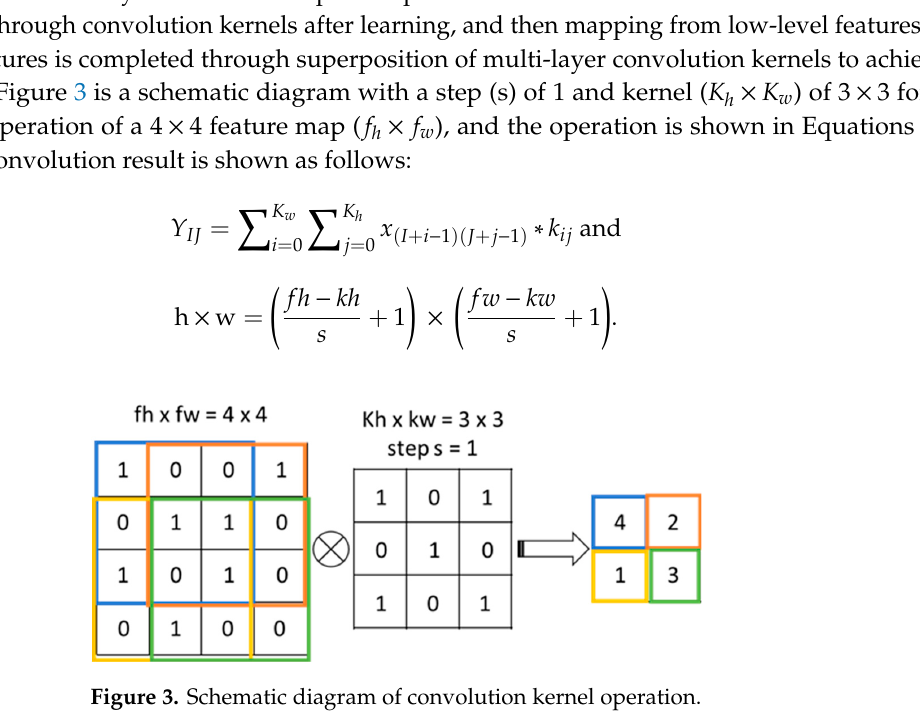
Figure 2. Schematic diagram of convolution neural networks.